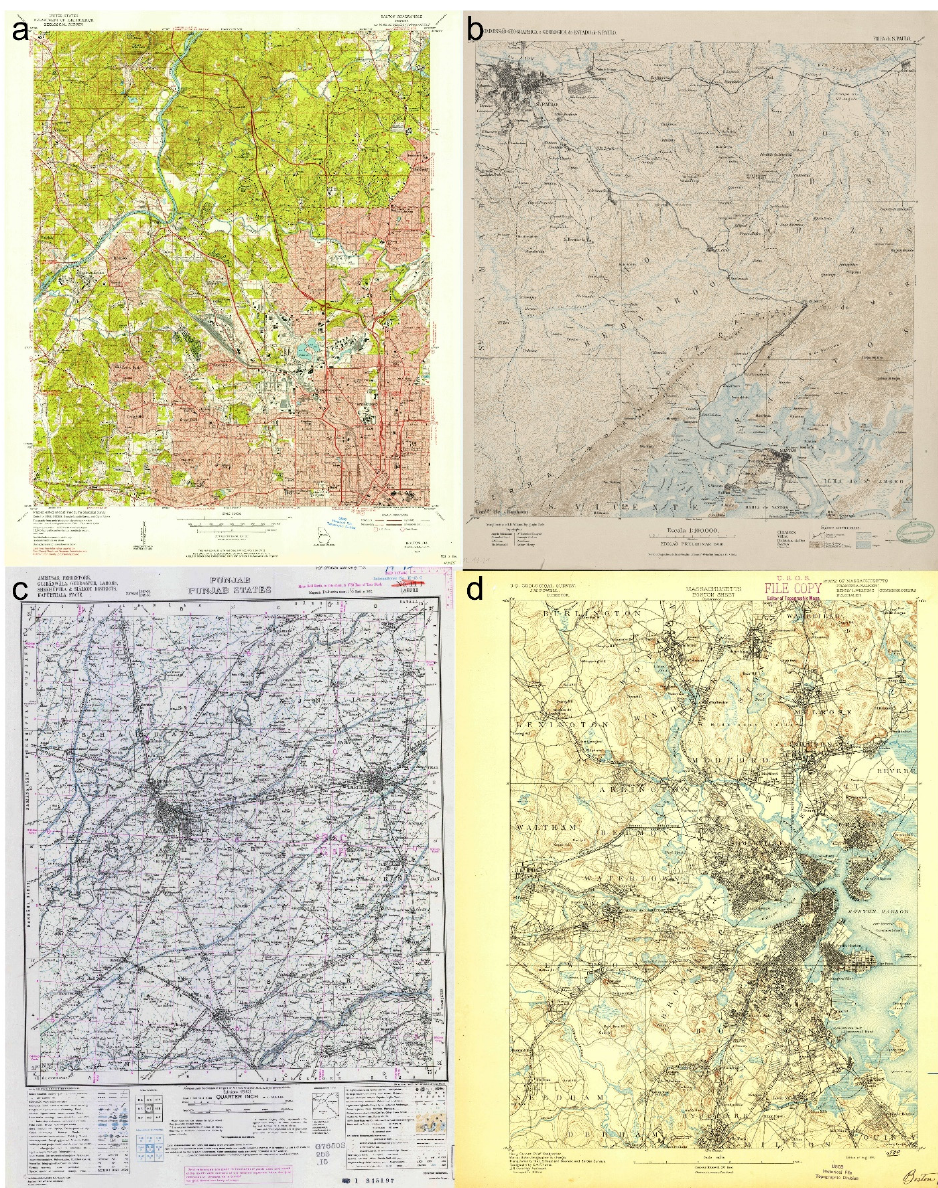
Figure A1. Selected scanned historical maps used in this study. ( a ) Northwest Atlanta (US) 1954, ( b ) Sao Paulo (Brazil) 1908, ( c ) Lahore/Amritsar (Pakistan/India) 1946, and ( d ) Greater Boston (US) 1893. Source ( a , d ): https://ngmdb.usgs.gov/topoview/viewer (accessed on 13 September 2021), Source ( b ): http://1886.u-bordeaux-montaigne.fr/items/show/10037 (accessed on 13 September 2021), Source ( c ): https://maps.lib.utexas.edu/maps/topo/india_253k/ (accessed on 13 September